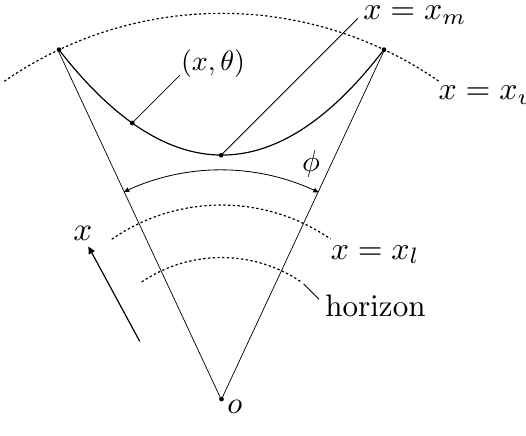
Figure 3 . The con(cid:12)guration of the fundamental string in the space spanned by the coordinates ( x; (cid:18) ). The string hangs down from the end points at x = x u . It reaches x = x m at the bottom. The bottom needs to satisfy x m > x l so that the string lies only in the valid spacetime